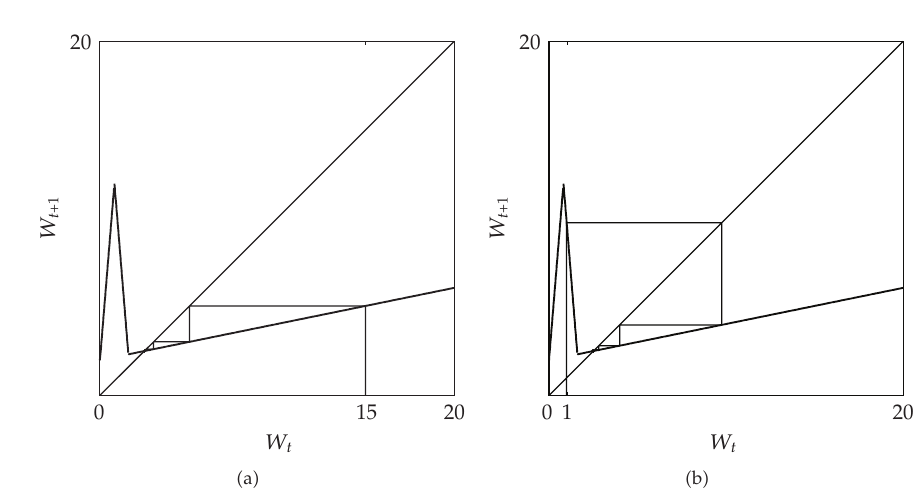
Figure 3: Koenigs Lemerary staircase diagram for two di ff erent initial conditions: in (cid:3) a (cid:4) , W 0 (cid:7) 15 > W (cid:4) while in (cid:3) b (cid:4) , W 0 (cid:7) 1 < W (cid:4) . In both cases μ (cid:7) 3